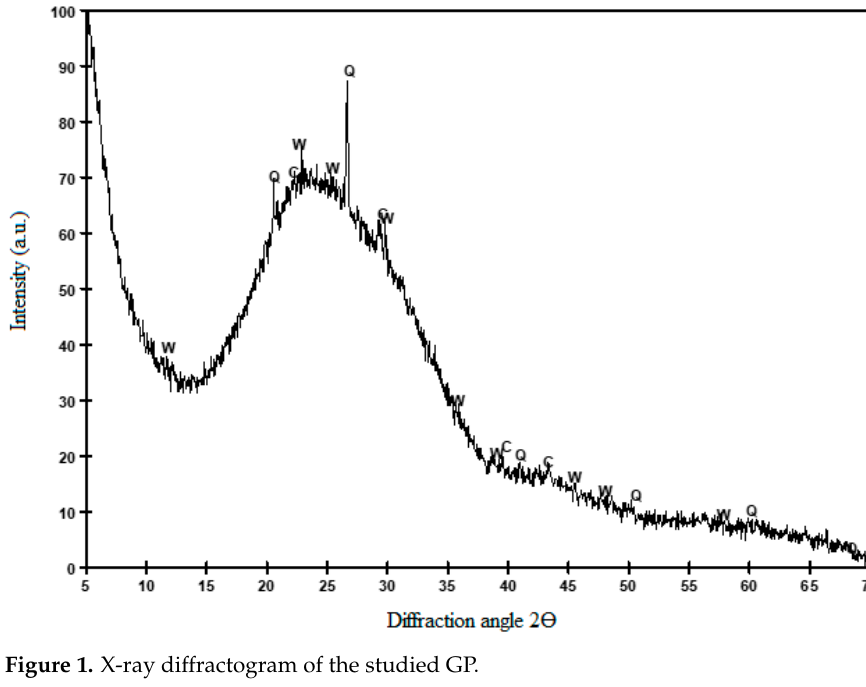
Figure 1. X-ray diffractogram of the studied GP.